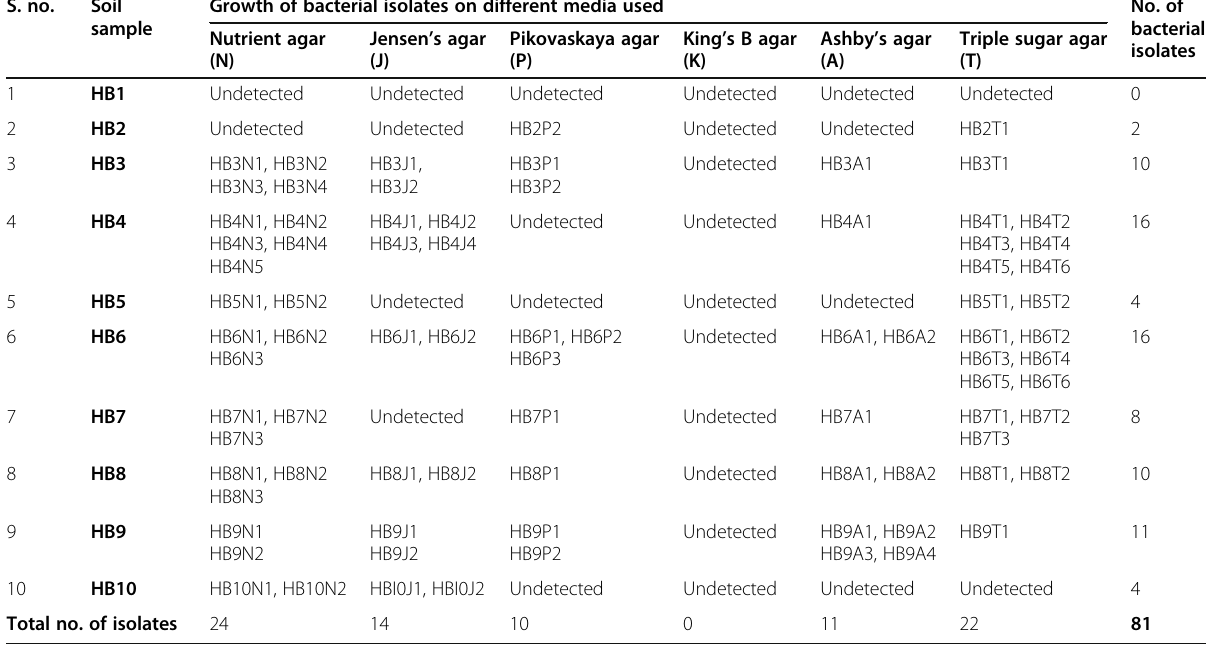
Table 2 Details of bacteria isolated from soil samples of Jhajjar, Haryana, India S. no. Soil sample